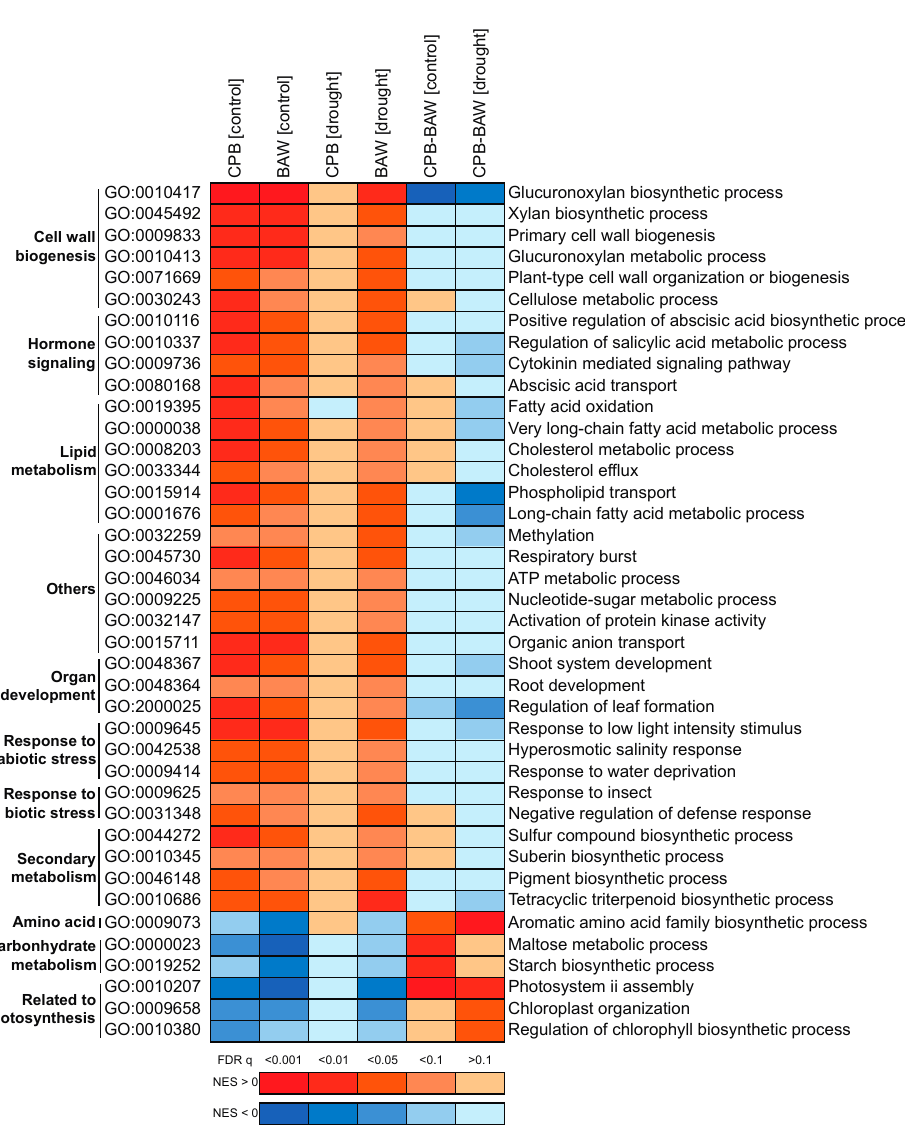
Figure 9. Herbivore-induced biological processes in Solanum dulcamara that were no longer Figure 9. Herbivore ‐ induced biological processes in Solanum dulcamara that were no longer significantly induced by Leptinotarsa decemlineata (CPB) feeding on drought ‐ stressed plants. Each column is a pairwise comparison between two conditions to show the effects of herbivory by Spodoptera exigua or L. decemlineata under well ‐ watering conditions (BAW (control) and CPB (control), respectively) or drought treatment (BAW (drought) and CPB (drought), respectively) or to show differences between herbivory treatments by the two insects on well ‐ watered (CPB ‐ BAW (control)) or drought ‐ stressed plants (CPB ‐ BAW (drought)). Colours indicate directions of the BP enrichment based on normalized enrichment scores (NES) generated by gene set enrichment analyses: red for upregulation (positive NES) and blue for downregulation (negative NES); higher absolute values of NES indicate more significant differences. Colour scales indicate levels of significance based on the associated false discovery rate (FDR) q values. Cut ‐ off for significance is set at q = 0.1. GO: gene ontology number. GOs of the same class were grouped. 3. Discussion In this study, we found that the performance of BAW, but not CPB, was reduced when feeding on S. dulcamara plants under drought stress. Correspondingly, herbivory by CPB and BAW induced different hormonal and transcriptional responses in S. dulcamara under well ‐ watered, control, and drought conditions.